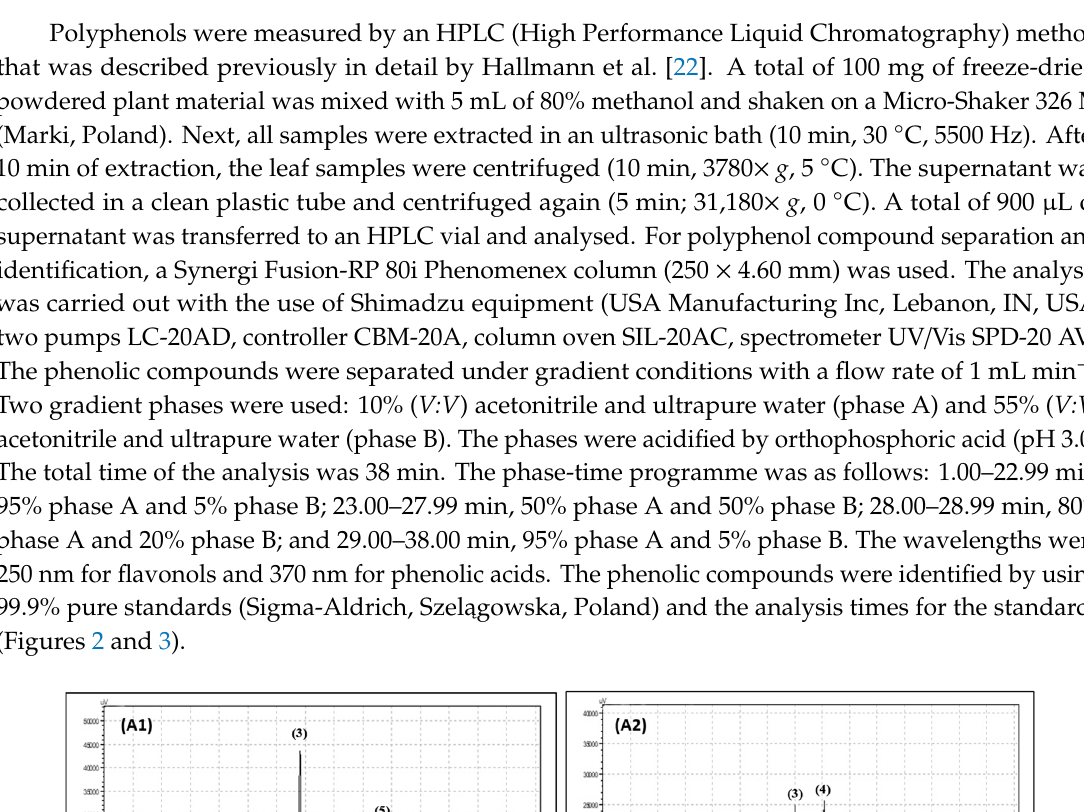
Figure 3. Chromatogram showing retention times for organic raspberry ( B1 ) and conventional raspberry leaves ( B2 ) flavonoids: (1) quercetin-3 -O- rutinoside, (2) myrycetin, (3) quercetin-3- O - glucoside, (4) quercetin, (5) luteolin. 2.5. Carotenoid and Chlorophyll Separation and Identification Carotenoids and chlorophylls were measured by an HPLC method, as described by Hallmann et al. [22]. Sample preparation included extraction of 100 mg of freeze-dried sample with 100% acetone using an ultrasonic cold bath (10 min, 0 °C). Samples were then centrifuged (10 min, 3780× g , 0°C). One millilitre of supernatant was transferred into an HPLC vial. The HPLC setup used to determine carotenoids and chlorophylls consisted of two LC-20AD pumps, a CMB-20A system controller, an SIL-20AC autosampler, an ultraviolet–visible SPD-20AV detector, a CTD-20AC oven and a Max-RP 80A column (250 × 4.60 mm), which are all Shimadzu products (Polish agent Shimpol, Warsaw, Poland). Methanol + acetonitrile (phase A) and methanol + ethyl acetate (phase B) at a flow rate of 1 mL min -1 were used as the gradient solvents (1.00–14.99 min, 100% phase A, 15.00–22.99 min, 40% phase A; and 24.00–27.00 min, 100% phase A). The wavelength used for detection was 445–450 nm. The carotenoid and chlorophyll concentrations were calculated using standard curves and the sample dilution coefficient and presented in mg per 100 g of fresh material. Identified carotenoids and chlorophylls are presented in Figure 4. Figure 4. Chromatogram showing retention times for organic raspberry ( C1 ) and conventional raspberry leaves ( C2 ) carotenoids and chllorophylls: (1) lutein, (2) zeaxanthin, (3) neoxanthin, (4) violaxanthin, (5) chlorophyll b, (6) chlorophyll a, (7) alpha-carotene, (8) beta-carotene.